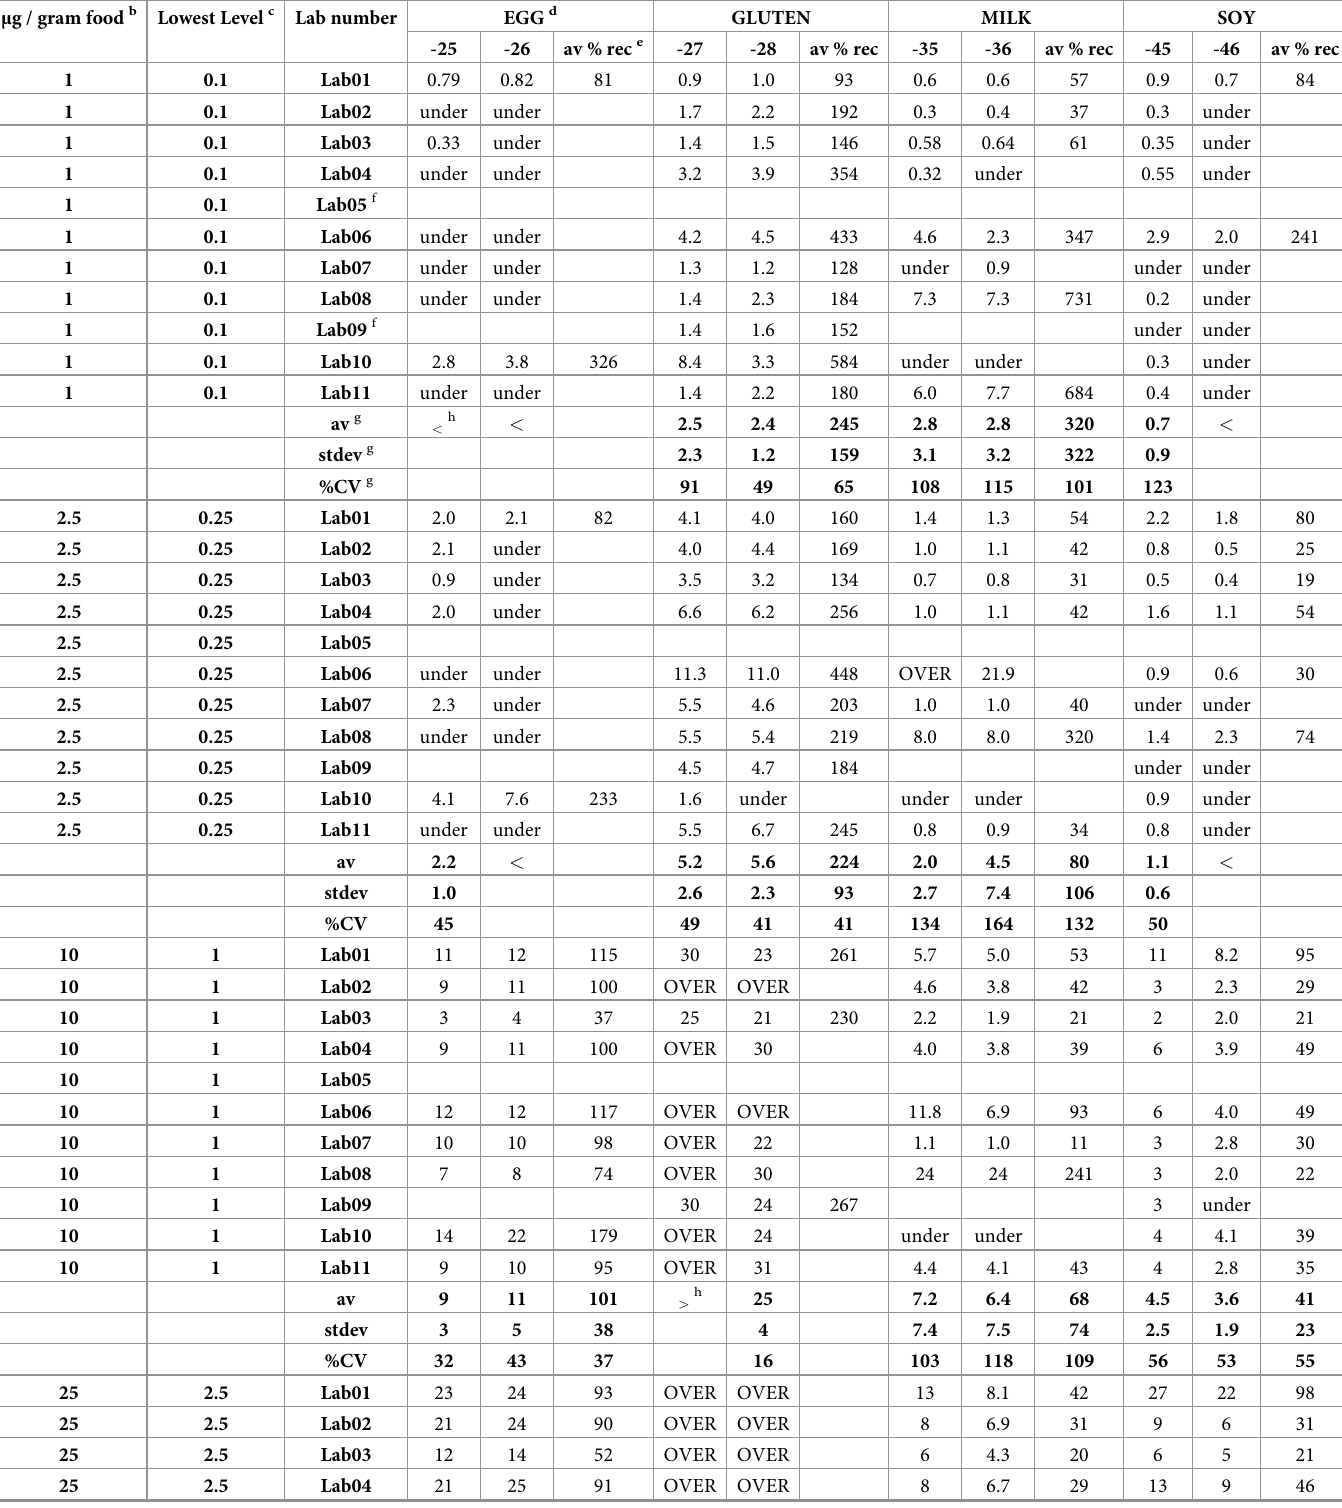
Table 12. Interpolated analyte recovered from incurred food samples: Meat / Sausage a